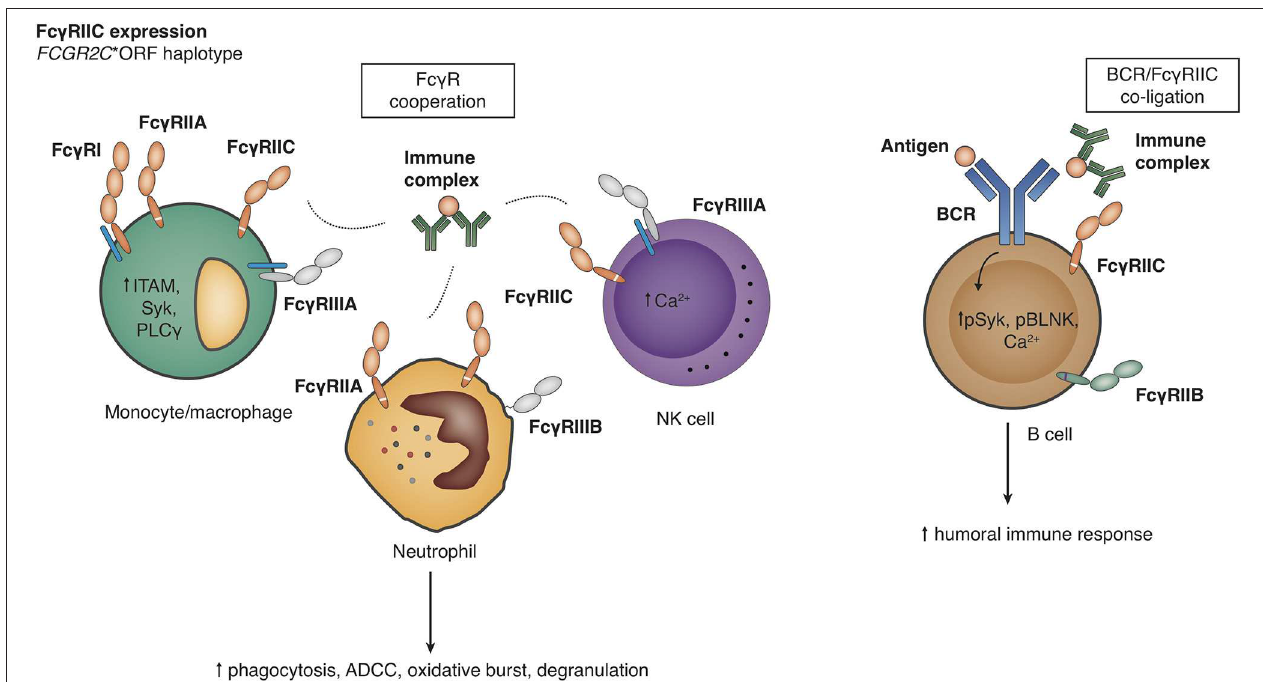
FIGURE 6 | Functional consequences of the FCGR2C- open reading frame (ORF) haplotype. Detailed explanations are given in the main text. Right panel, Effects on the level of B cells have been described by Li et al. ( 18), but other analyses have not shown Fc γ RIIC expression on B cell surface in FCGR2C- ORF individuals